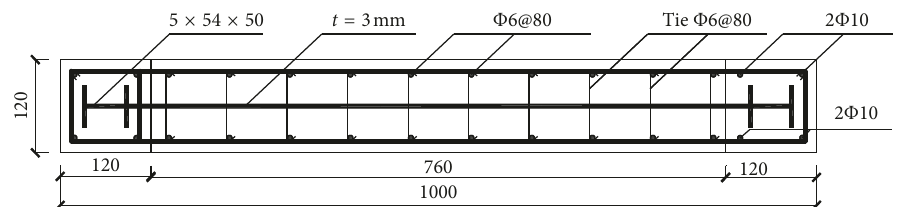
Figure 9: Typical section of the parametric study.